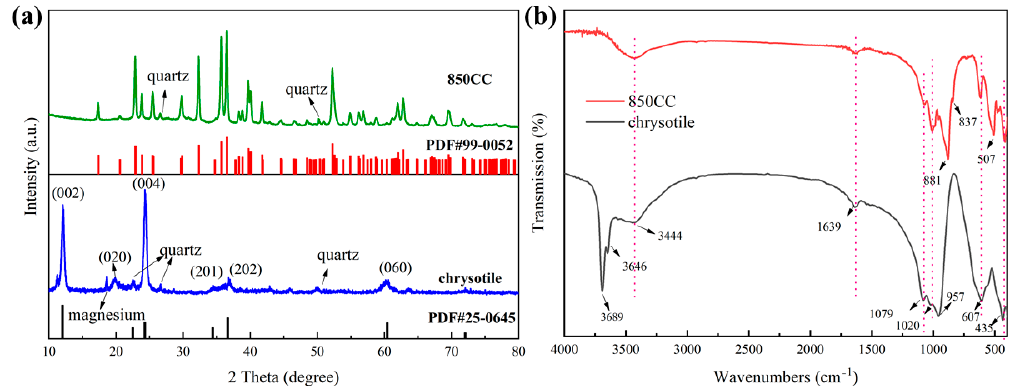
Figure 3. The XRD patterns ( a ) and FTIR spectra ( b ) of 850CC and raw chrysotile. FTIR was employed to confirm the change in valence bonding and functional groups of 850CC and raw chrysotile (Figure 3b). In the FTIR spectrum of chrysotile, the obvious peaks at the 1079, 1020 and 957 cm − 1 are indexed to the stretching vibration of Si-O-Si, Si-O-Mg and Si-O, respectively [33], indicating that the chrysotile structure is perfect. In the FTIR spectrum of 850CC, the characteristic peak of 1020 cm − 1 disappears, and two new peaks appear at 881 and 837 cm − 1 corresponding to Si-O-Si and Si-O stretching vibration of forsterite, which further confirms the formation of forsterite [34]. Bands at 3646 and 3689 cm − 1 in the FTIR spectrum of chrysotile can be attributed to the vibration of the outer and inner hydroxyl groups of Mg-OH in the structure [35]. However, these bands are not detected in the FTIR spectrum of 850CC, which proves that there are no hydroxyl groups on the surface. Bands at 3444 and 1639 cm − 1 in both FTIR spectra are due to the adsorption of water molecules in the air on the sample surface [31].